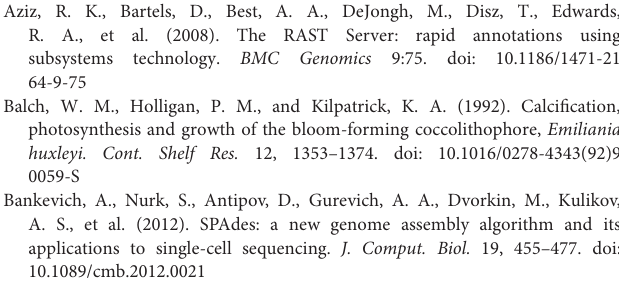
FIGURE S1 | Flow chart detailing the bioassay guided fractionation process that was used to eventually identify HHQ as a causative compound influencing growth of E. huxleyi . FIGURE S2 | Structural identification of 2-heptyl-4-quinolone (HHQ) from P. piscicida . 13 C-NMR spectrum (75 MHz, DMSO- d 6 ) of the pure compound isolated from P. piscicida (blue) and the authentic standard HHQ (red). FIGURE S3 | Genome mining of pqs operon in Pseudoalteromonas sp. (A) The pqs operon from two species of Pseudomonas aeruginosa PAO1 were used to query 67 publically available Pseudoalteromonas sp. genomes. Joint Genome Institute (JGI) genome accession numbers are listed for each isolate in parentheses. Red boxes indicate the presence of a homolog and black boxes indicate no homolog identified with BLAST cutoffs set at ≥ 10% identity and a maximum e-value of 0.01. White asterisks indicate two homologs ( pqsB and pqsE ) from P. citrea that were initially identified as absent in the genome using the Integrated Microbial Genome (IMG) gene-genome comparison analysis, but upon manual inspection, were found to be present. (B) A comparison of the alkylquinoline biosynthetic pathway in Pseudoalteromonas piscicida (A757; GenBank Accession no., KT879191–KT879199) and P. citrea (NCIMB 1889). Shading of homologs in P. citrea indicates percent amino acid identity to P. piscicida (A757) genes. FIGURE S4 | Growth rate ( µ d − 1 ) for three species of phytoplankton exposed to the crude extract of the secreted metabolites of P. piscicida . Despite HHQ having little effect on D. tertiolecta and P. tricornutum , toxicity to the crude extract of P. piscicida is observed in all species, indicating that P. piscicida likely produces additional compounds that result in algal mortality. Error bars are one standard deviation from the